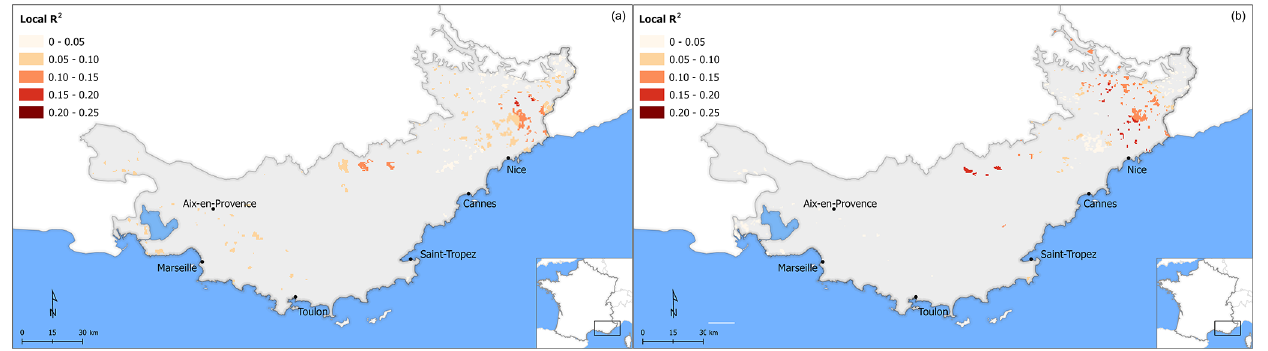
Figure 17. Spatial distribution of local R 2 between burned area and percent cover of natural grasslands for 1970–1994 (a) and 1995–2019 (b) .